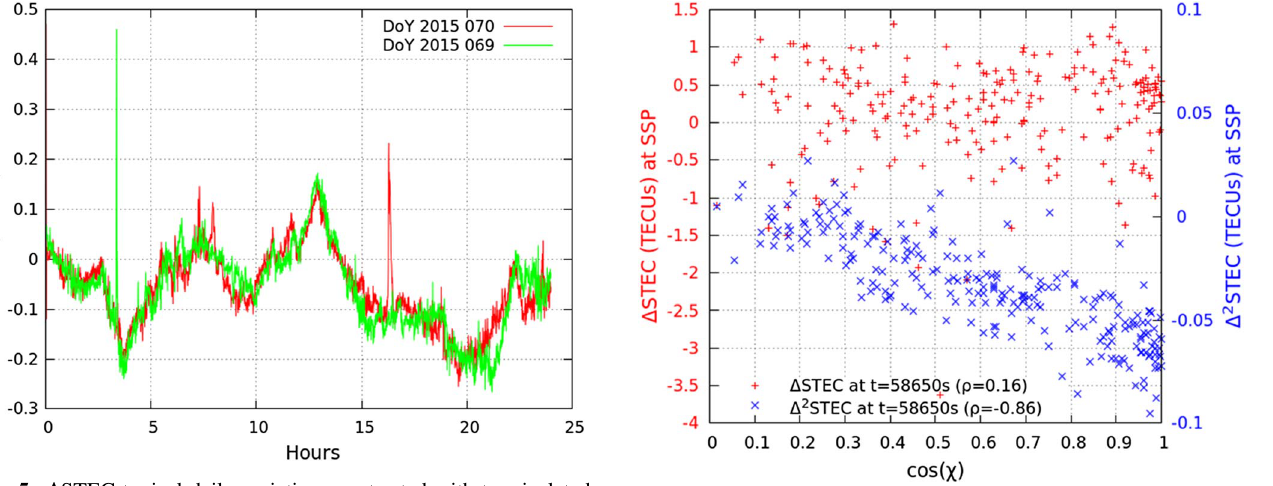
Fig. 5. D STEC typical daily variations contrasted with two isolated peaks due to the occurrence of SFs, at around 04:00 and 16:00 hours UTC of the days 10 and 11 of March 2015, respectively.